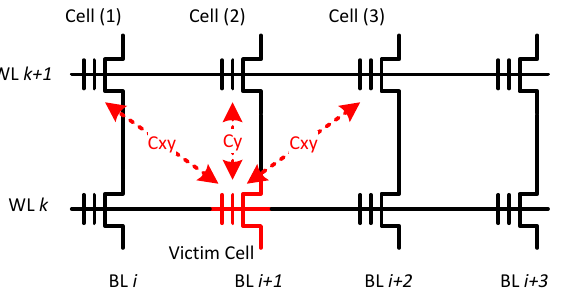
Figure 1. Illustration of the parasitic coupling capacitances among adjacent